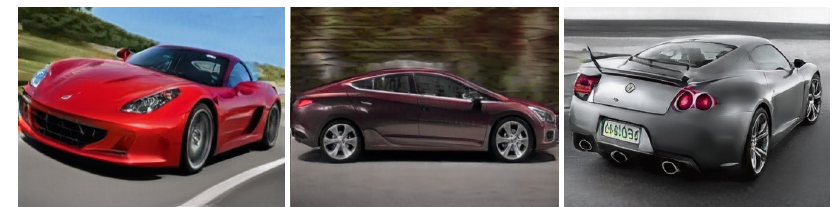
Figure 9. Images of cars generated by our trained StyleGAN neural network using the proposed LSUN-Stanford car dataset.